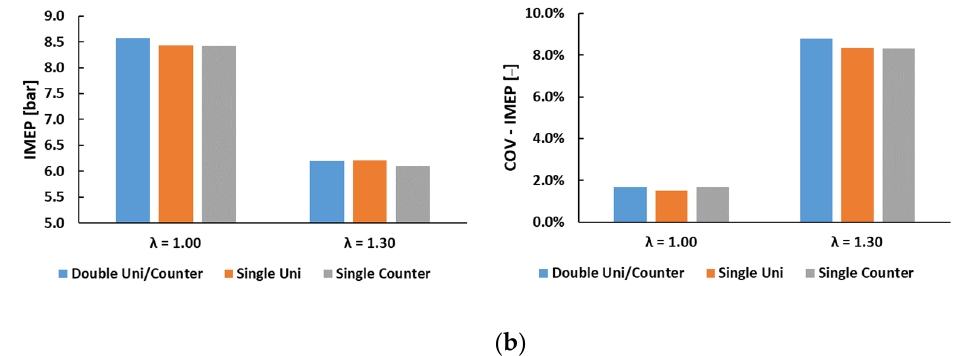
Figure 11. ( a ) In-cylinder pressure traces (top) and ( b ) mean IMEP and COV values for both spark plug designs and uni-/counter-flow orientations ( λ = 1.00–1.30, SA 12 CAD).